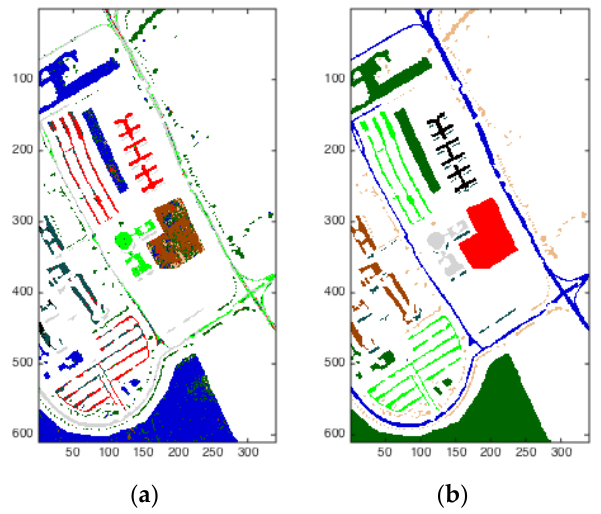
Figure 9. Pavia University. ( a ) Classification map based on DBN and SOM; ( b ) Reference data.